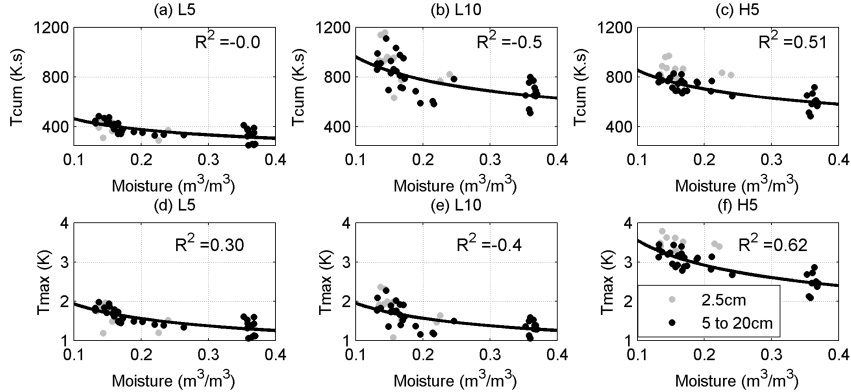
Figure 7. Same as Figure 4 but without background temperature